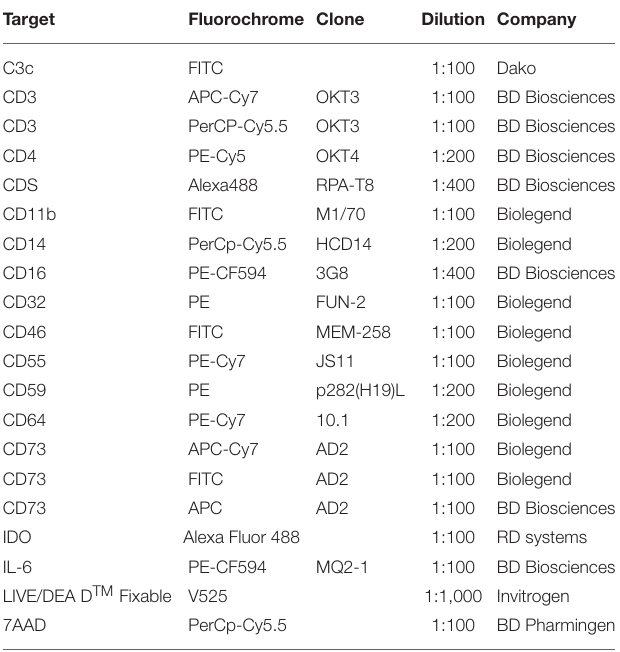
TABLE 1 | Antibodies used in the current